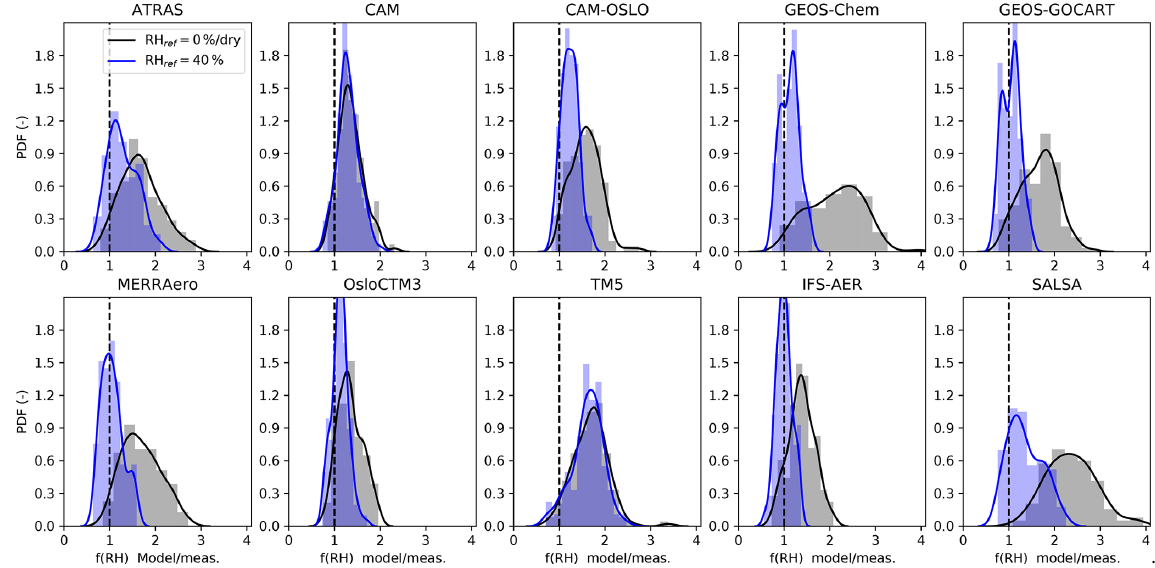
Figure 6. Probability density functions of the ratio f (RH) model /f (RH) meas for all sites for each model. The blue values denote the ratios if RH = 40% is taken as reference RH. The gray areas represent the ratio if RH ref = 0% (models) or RH ref = dry (measurements) is